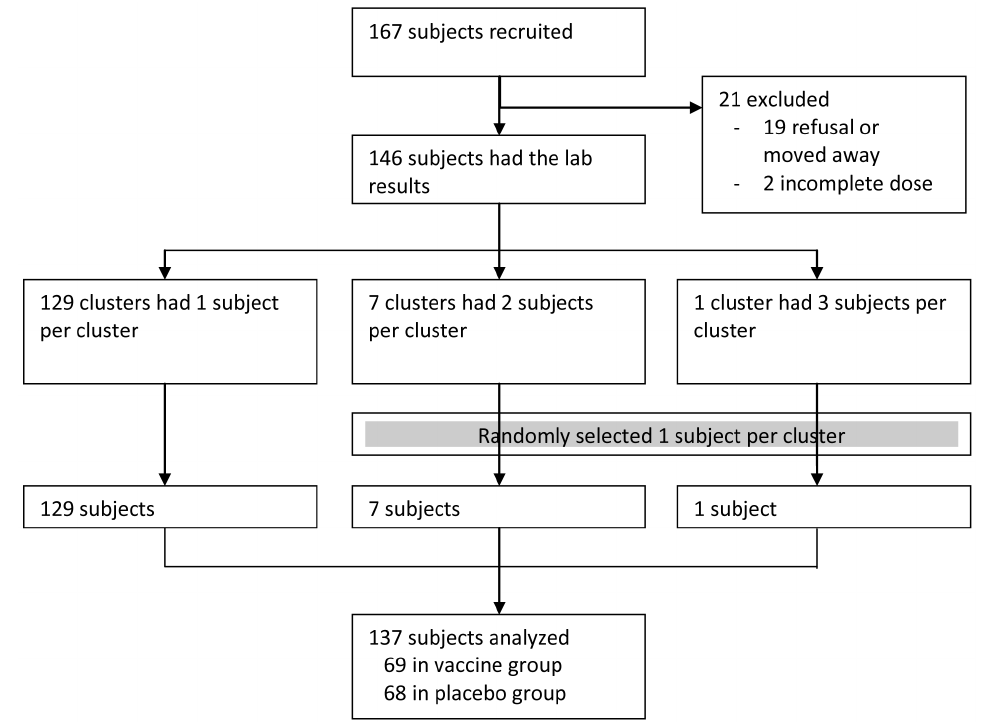
Figure 1. CONOSRT for assembling the subjects.